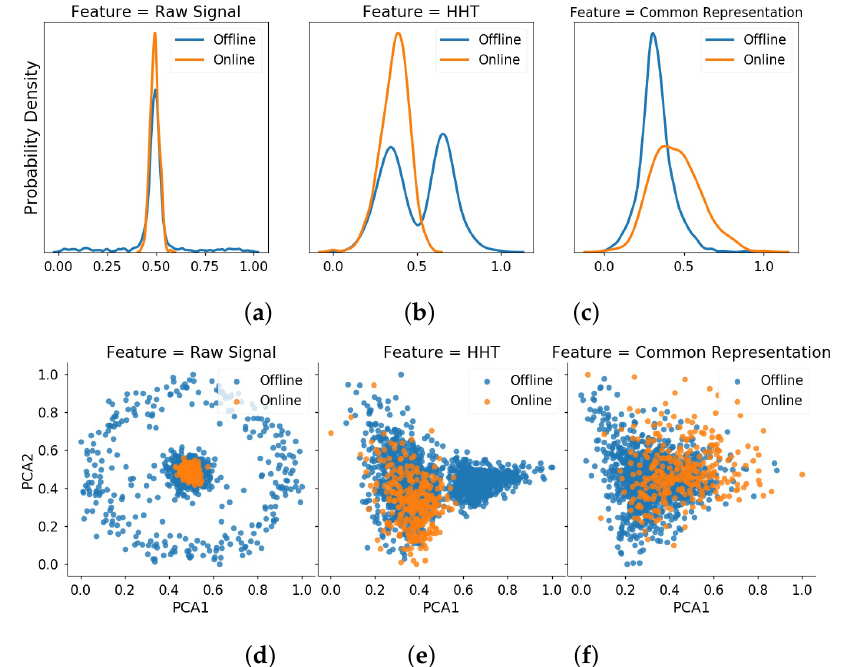
Figure 19. Comparative distribution of Target 2 and six training bearings, with ( a – c ) the probability density distribution of raw time signal, HHT marginal spectrum, the common deep features by domain adaptation DAE, and ( d – f ) the feature distribution corresponding to ( a – c ),